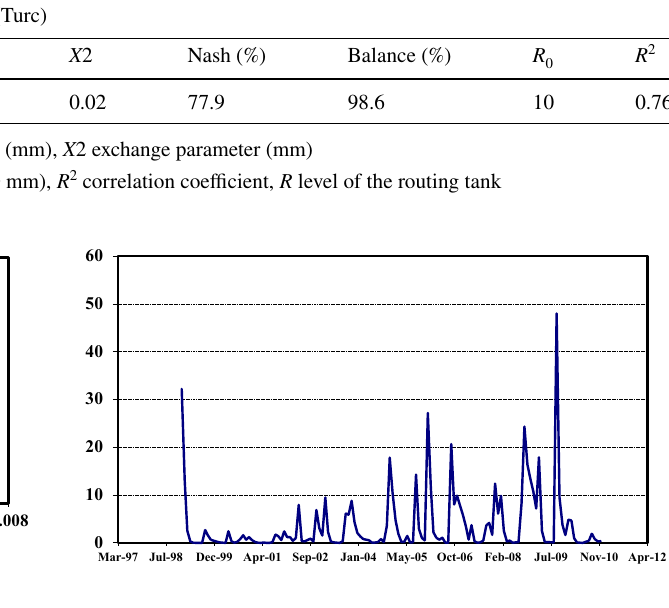
Curve indicating the level S of the production reservoir